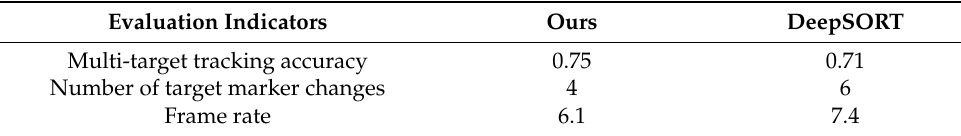
Table 7. Results of tracking metrics in the test